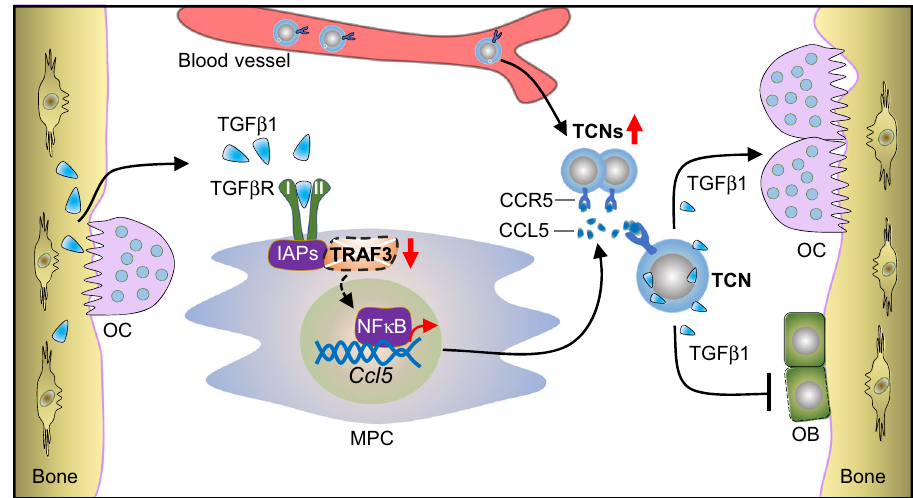
Fig.9|ModelforhowTGF β 1-TRAF3axisaffectsbonemassduringaging. During aging, increased TGF β 1 protein levels in the bone microenvironment cause decreased bone mass. TGF β 1 targets mesenchymal progenitor cells (MPCs) by binding to its receptors to trigger TRAF3 degradation, leading to excessive NF- κ B- mediated CCL5 expression by MPCs. TGF β 1 + CCR5 + neutrophils (TCNs), the major cellularsourceofTGF β 1inBM,arerecruitedfromperipheralbloodintoBMduring aging, associated with increasedCCL5 levels, resulting in inhibited osteoblast (OB) differentiation and enhanced osteoclast (OC) formation. As we